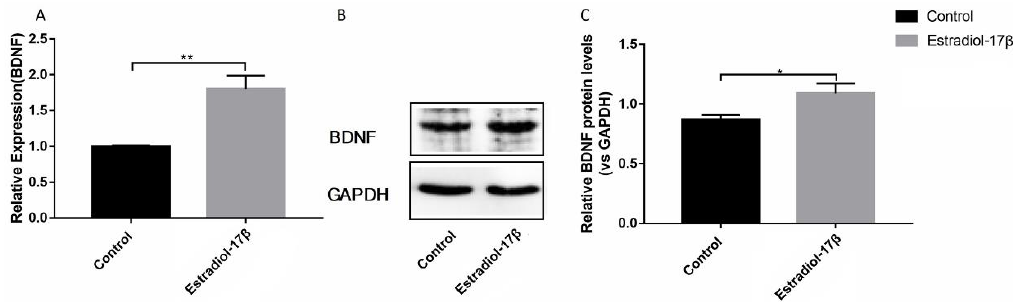
Figure 2. E 2 up-regulated transcription / translation of BDNF in the Ishikawa cells. ( A ) Relative mRNA expression levels of BDNF gene were detected by qRT-PCR. ( B ) Protein levels of BDNF genes were detected by Western blot analysis. ( C ) Relative protein levels of BDNF genes were analyzed by grey scanning. The expression levels of mRNA and proteins were normalized by the GADPH gene, which plays an important role as an internal reference calibration for qRT-PCR and Western blot analysis. Statistical analysis is shown. * p < 0.05, ** p < 0.01.